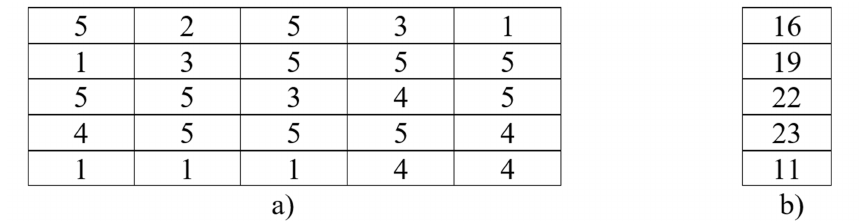
Figure 14. ( a ) Matrix showing the pixels of an 5 × 5 image, ( b ) The vector resulting from projecting the matrix over its vertical